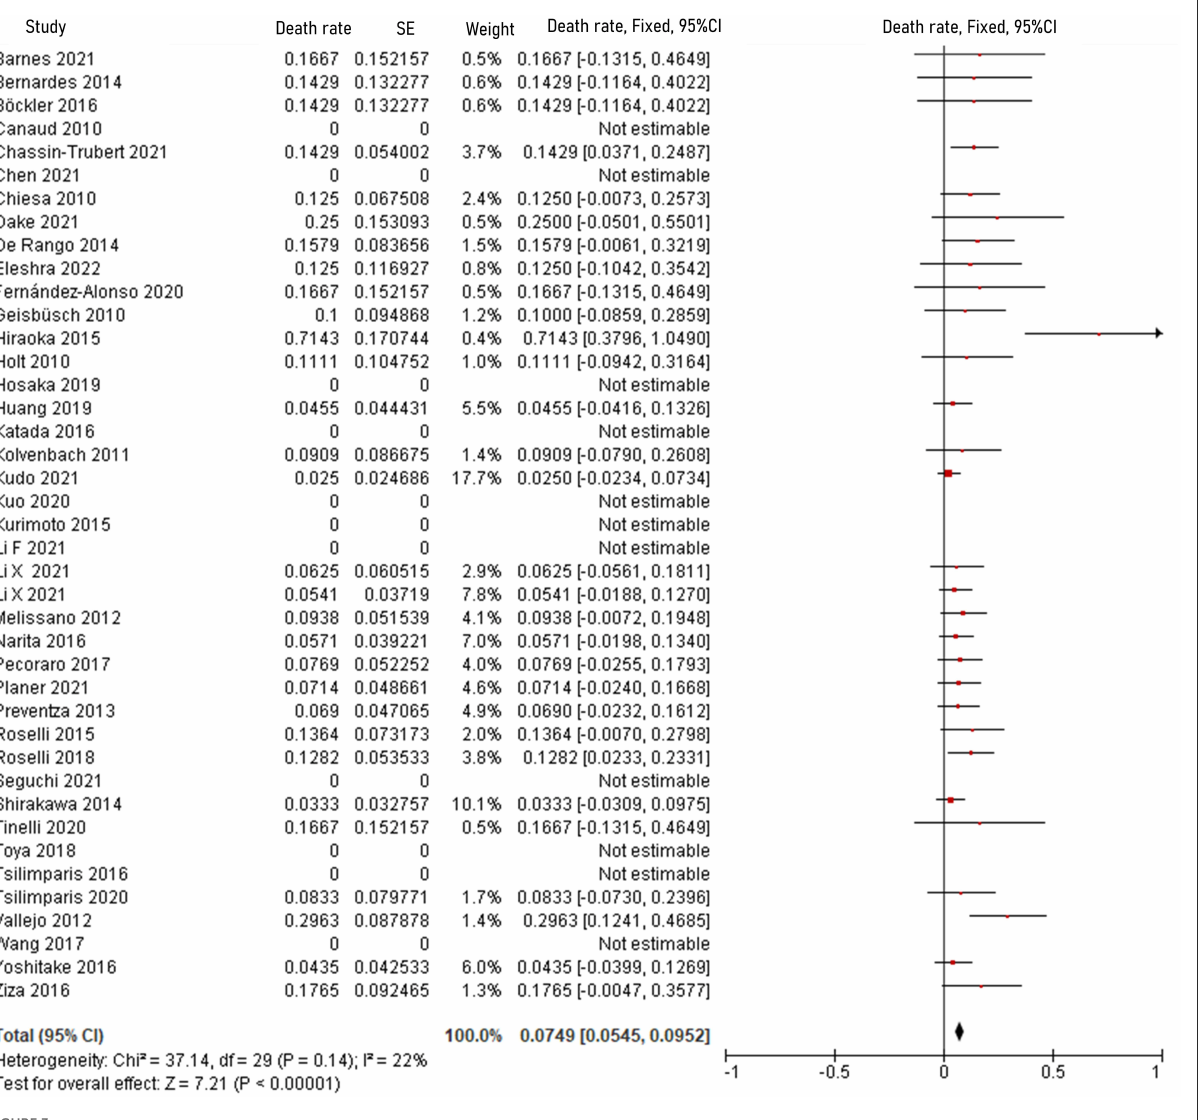
FIGURE3 Forest plot shows the fixed-effects proportion meta-analysis for perioperative death rate. CI, confidence interval; SE, standard